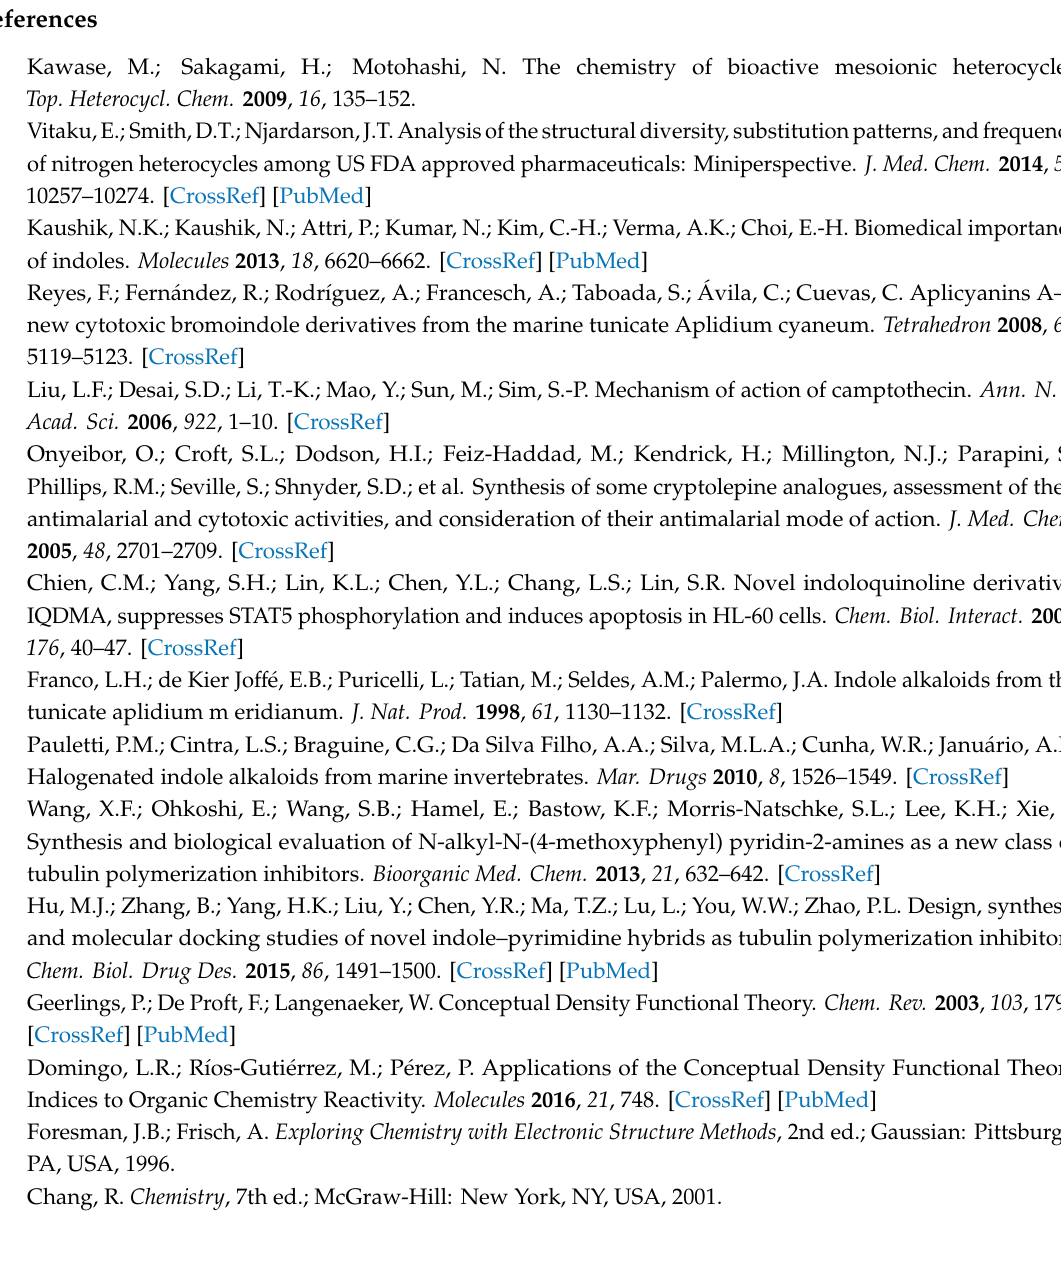
Table S2: Geometric parameters (bond distances (Å) and angles ( ◦ )) of the studied compounds; Table S3: The calculated geometric parameters (bond distances and angles) of the studied compounds; Figure S1: The optimized molecular structures of the studied